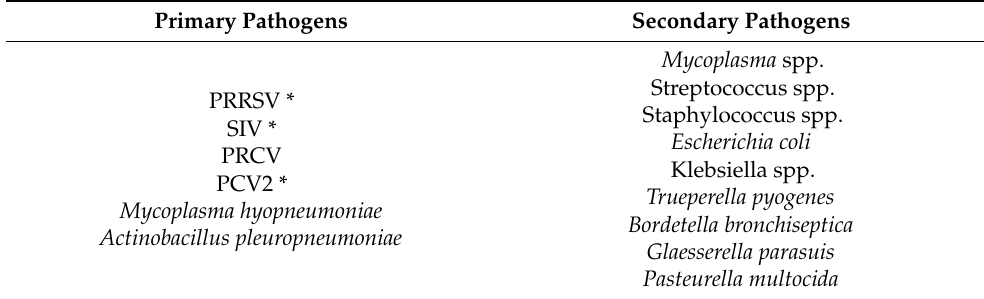
Table 1. Primary and secondary pathogens in porcine respiratory disease complex (PRDC)